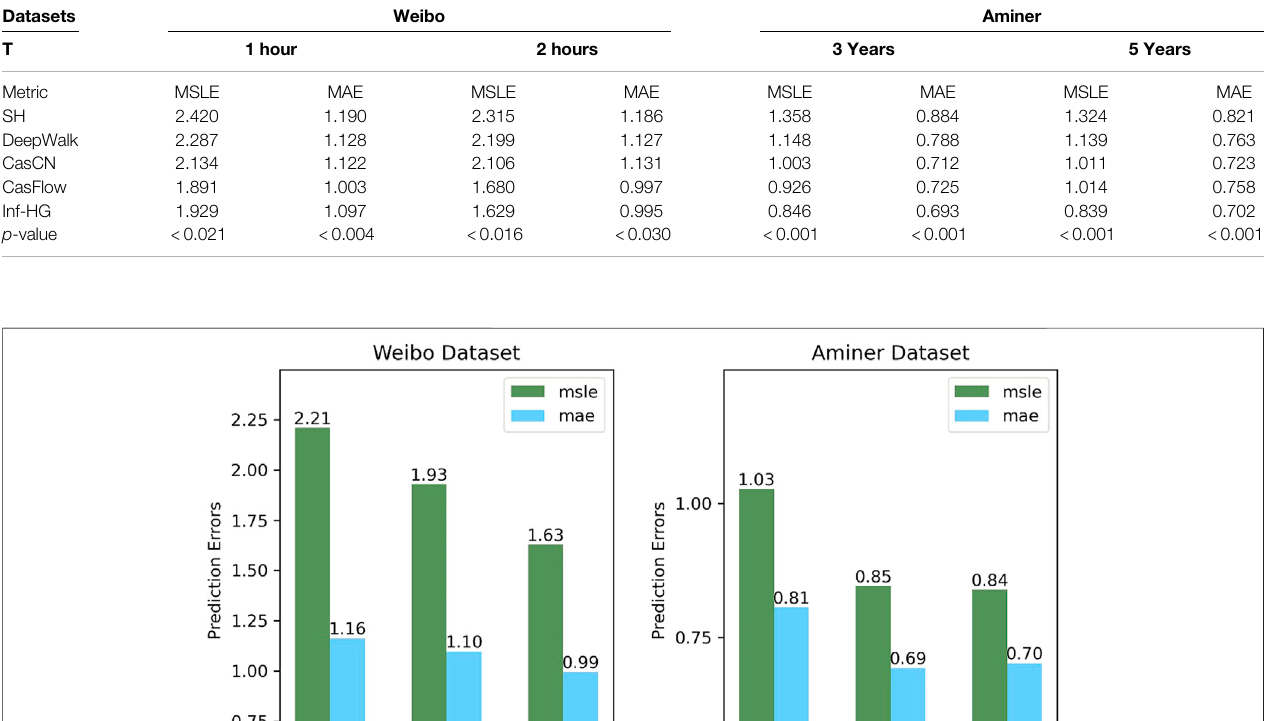
TABLE 2 | Overall performance comparison. Datasets